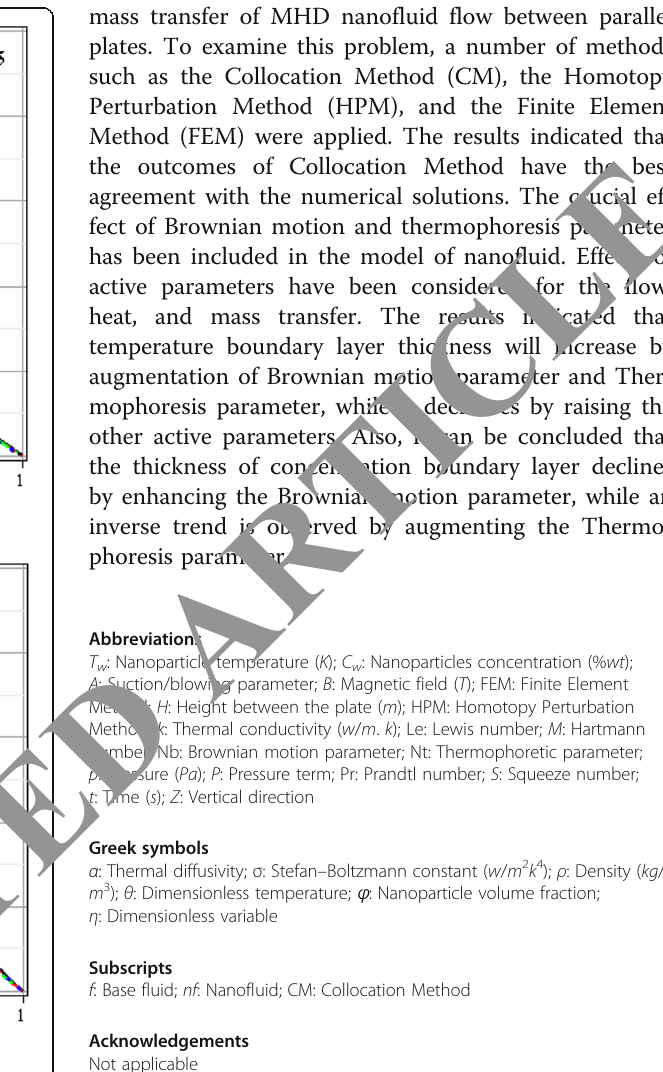
Fig. 9 a Effect of Le parameter on temperature distribution when Nt = 1, A = 1, M = 1, S = 1, Nb = 1, Pr = 6.2. b Effect of Le parameter on concentration distribution when Nt = 1, A = 1, M = 1, S = 1, Nb = 1, Pr =